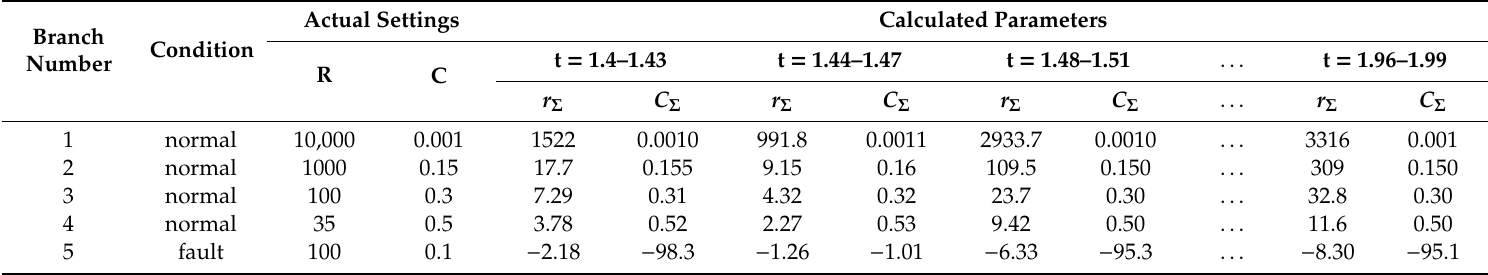
Table 1. The result of the emulate when the extreme circumstance of single-phase earth leakage fault occurred ( R g = 10 Ω ). (resistance: k Ω ; capacitance: µ F; time: ms).